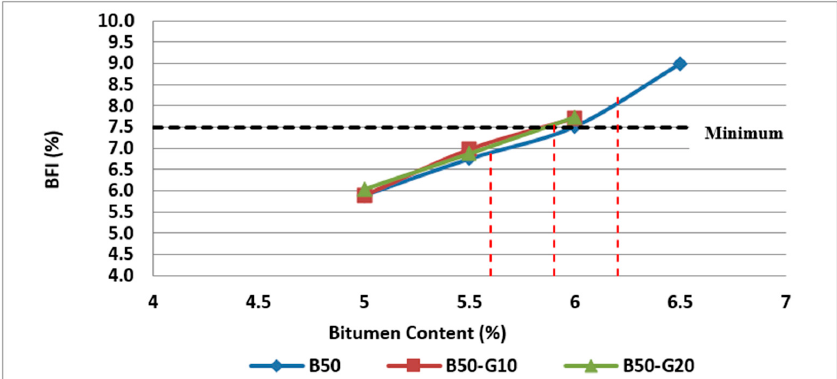
Figure 21. Effect of bitumen content and glass content on BFI of Mix III containing 50% RCA without glass and Mix VI and Mix VII containing 50% RCA as coarse aggregate and glass as fine aggregate.